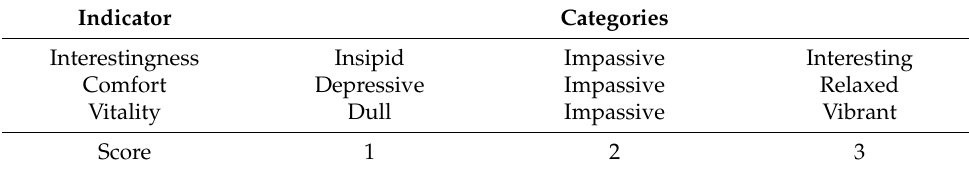
Table 2. Categories of subjective evaluation indicators and the respective scores.